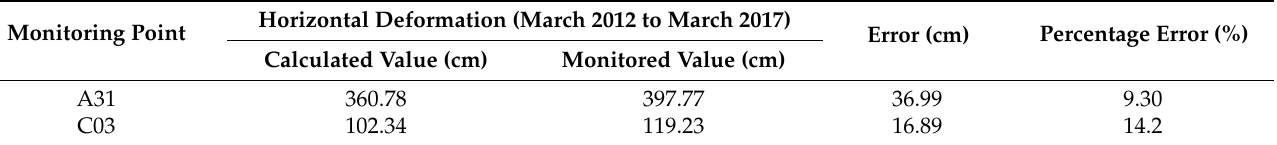
Table 6. Back analysis of the calculated and in situ monitored horizontal deformations.